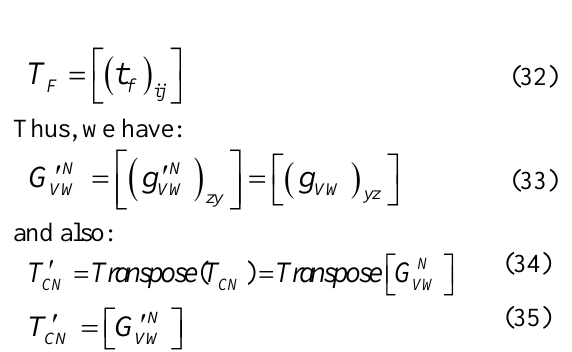
Figure 3. Causal-Effect diagram.